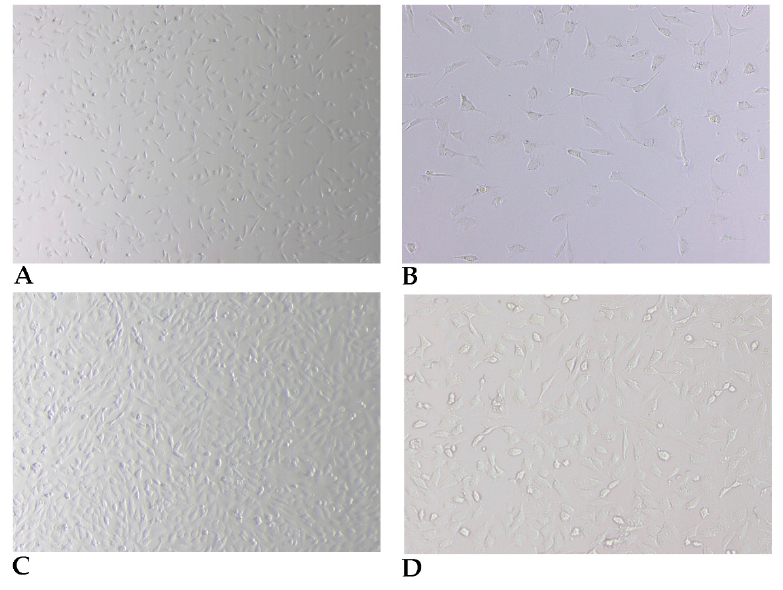
Figure 3. Phase contrast microscopy of typical fibroblast cells after step (7) of the Preparation of fibroblasts from skin biopsy procedure, at day 2, 40× ( A ) and 100× ( B ), and at day 4, 40× ( C ) and 100× ( D ). fibroblasts from skin biopsy procedure, at day 2, 40 × ( A ) and 100 × ( B ), and at day 4, 40 × ( C ) and 100 × ( D